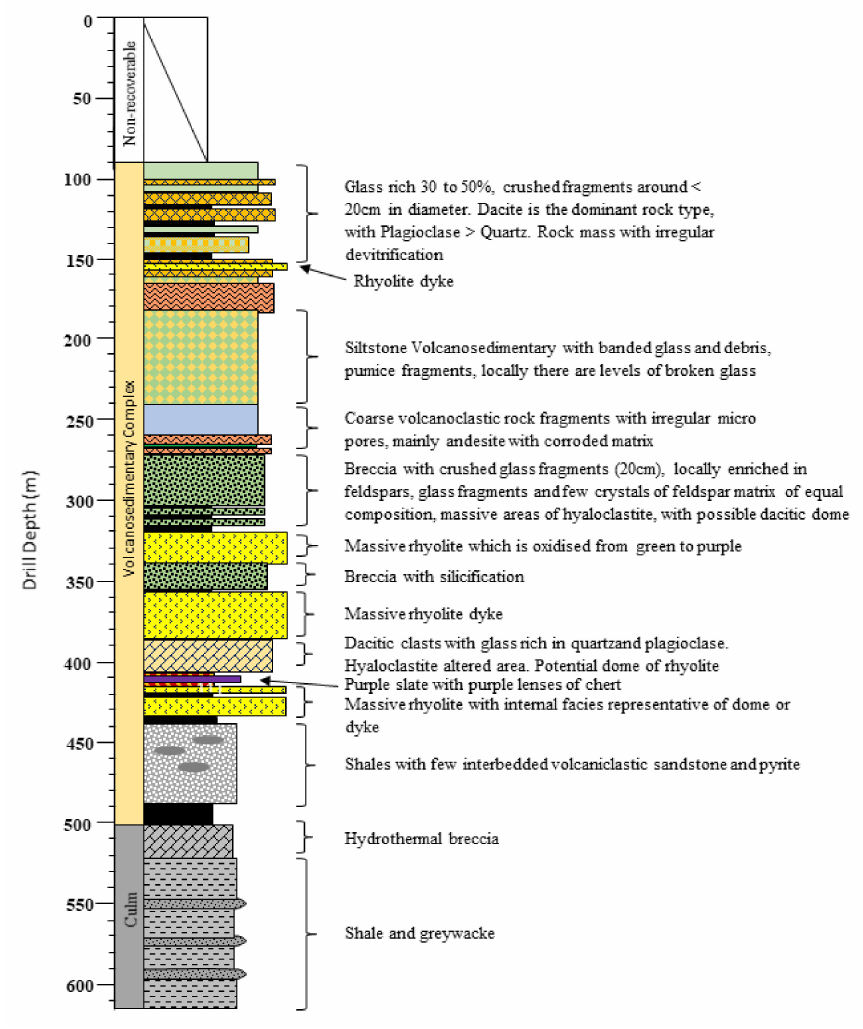
Figure 12. Stratigraphic column obtained from the materials drilled in BH10. The pH and Eh values from the springs show minor discrepancies, however in con- junction with the geochemical and SI data, it is indicated their acidity has various sources and relative contributions. The hydrogeologic framework, though it contains extensive fractures and faults, may not act as an efficient a conduit as once thought, limiting sub- surface interconnectivity (Figures 2 and S1) [20,23,42]. This idea is supported by the large spatial variation in pH values and lack of homogeneity. LHS and RHS Anabel’s Garden spring are a great example, with pH values of 2.72 and 1.99, respectively, yet they are around 10 m apart (Figure 6f,g). Variations in lithology and texture, in addition to the depth of burial, dictates permeability and tortuosity, and hence interconnectivity and flow rate, which need to be taken into consideration